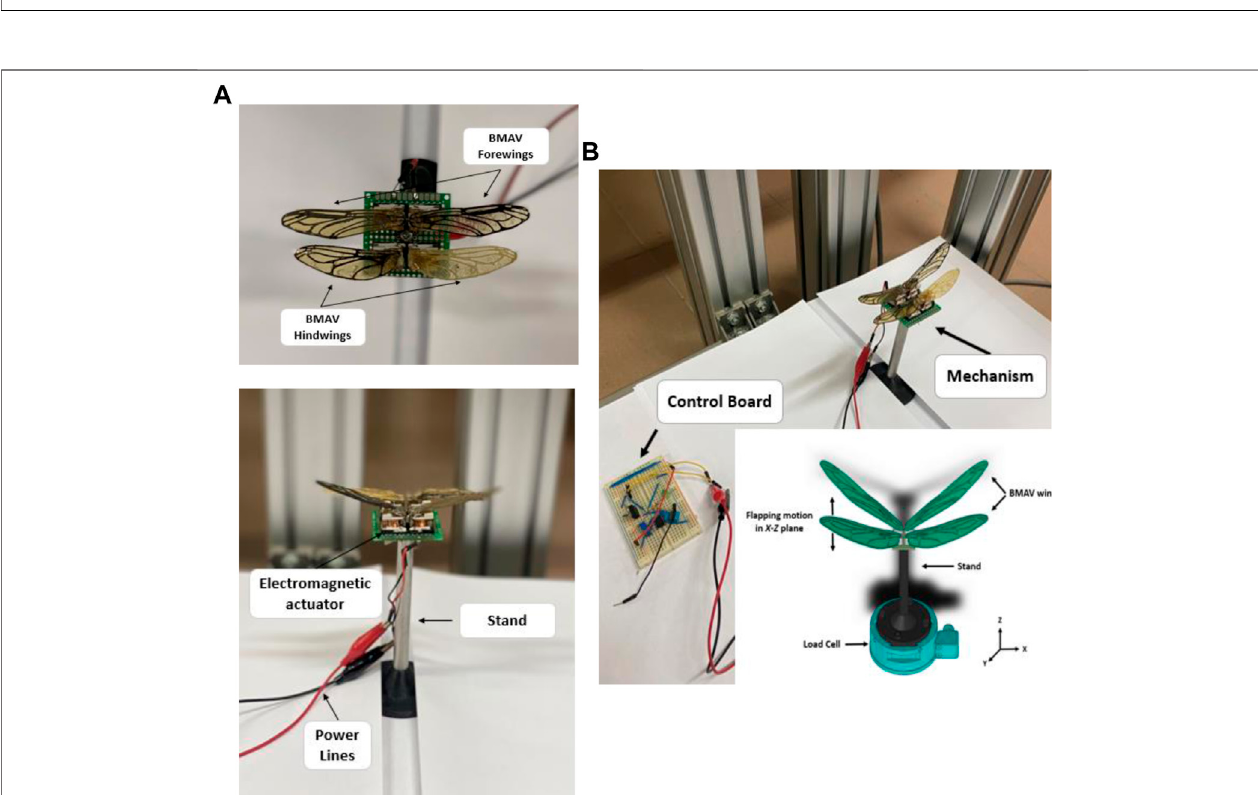
FIGURE 4 | (A) Wings and actuator formation, (B) Experimental